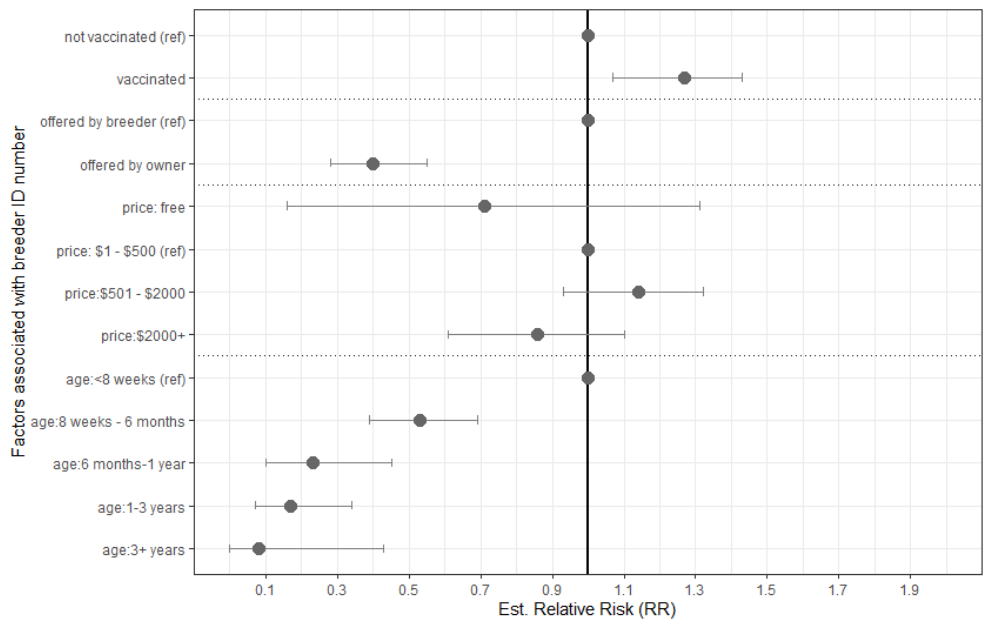
Figure 3. Estimated relative risk for predictors associated with advertisements including a breeder ID at time of sale in 648 unique online advertisements posted on Gumtree (webscraped on two separate days, 25 March and 8 April 2019), in states with regulations relating to breeder ID (SA, QLD, VIC) as found through multivariable logistic regression. Dataset excludes SA advertisements featuring dogs born prior to 1 July 2018, and QLD advertisements featuring dogs born prior to 26 May 2017 as breeder ID regulations did not apply. Predictors remaining were statistically significant to p < 0.005.